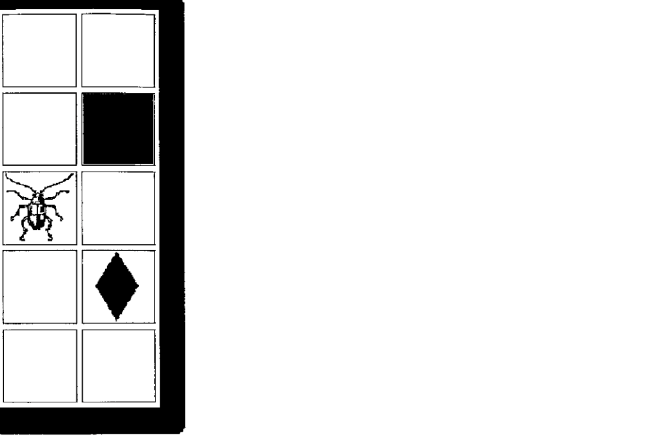
tive to constrain reference, Nadig and Sedivy (2002) [26] created three different visual conditions, as shown in Figure 4 below.